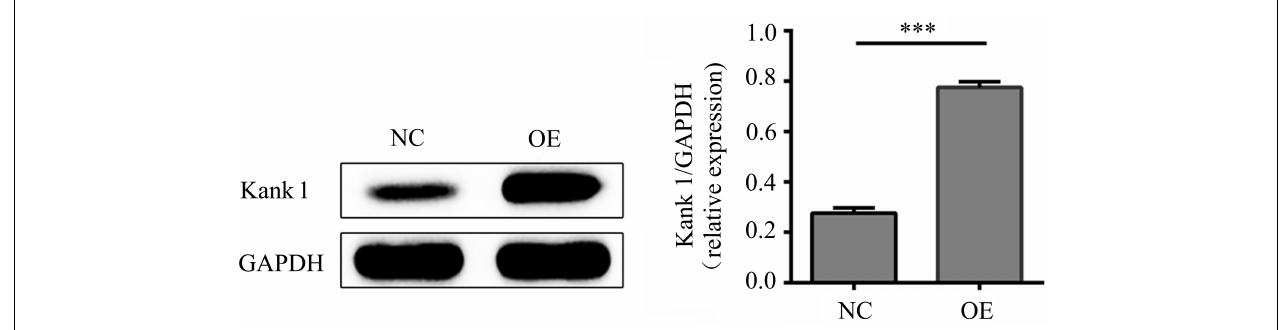
FIGURE 2 | The protein level of Kank1 in NC cells and OE cells was determined by Western blot analysis. The relative protein expression level of Kank1 in OE cells was significantly increased compared to that in NC cells (77.33 ± 2.08% vs. 27.67 ± 2.08%, *** P < 0.001). Student’s t -test was used for comparisons between two groups. Two-tailed P -values less than 0.05 were considered statistically significant.